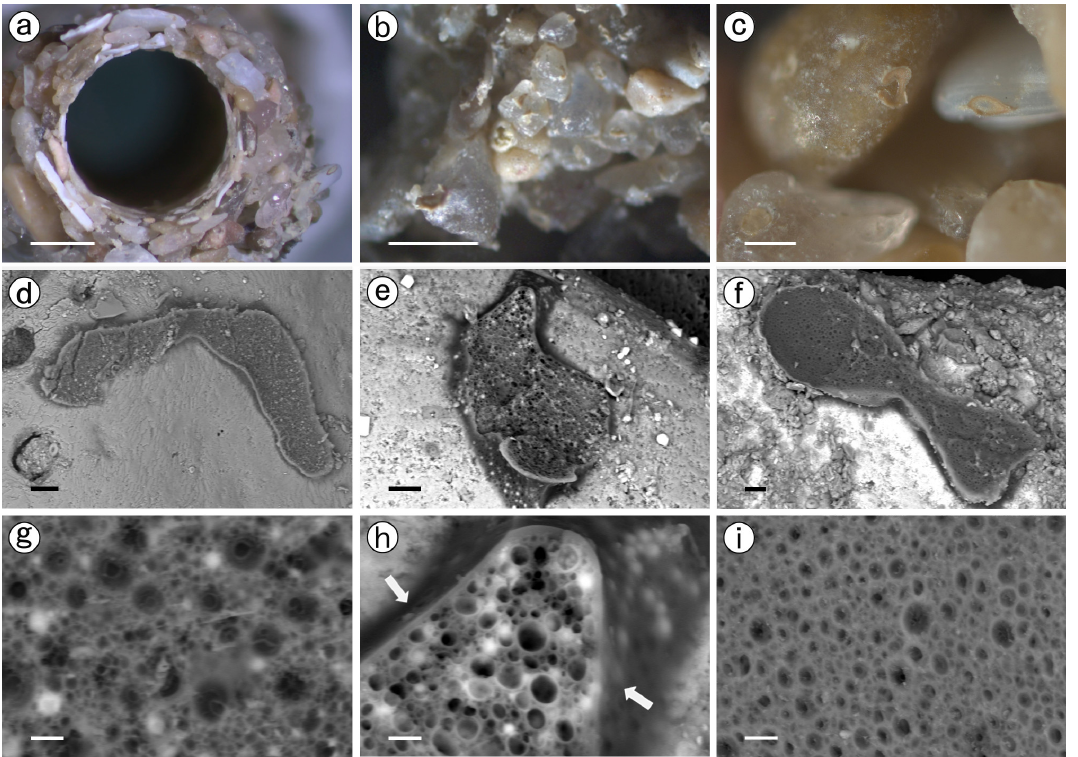
Figure 3Figure 3. ( a ) Apertural edge of an S. alveolata tube with obvious brown spots of biocement on some grains (Simeto); ( b ) detail of a tube wall with numerous biocement portions on sandy elements; ( c ) sand grains with biocement spots showing meniscus surfaces as they mold the morphology of the adjacent detached grains; SEM images of single biocement portions and related internal vacuolar structures from Portopalo ( d , g ), Simeto ( e , h ), and Falconara ( f , i ). The outer surface (white arrows) is indicated in ( h ). Scale bars: ( a ) 1 mm; ( b ) 500 µ m; ( c ) 200 µ m; ( d ) 20 µ m; ( e , f ) 10 µ m; ( g – i ) 2 µ